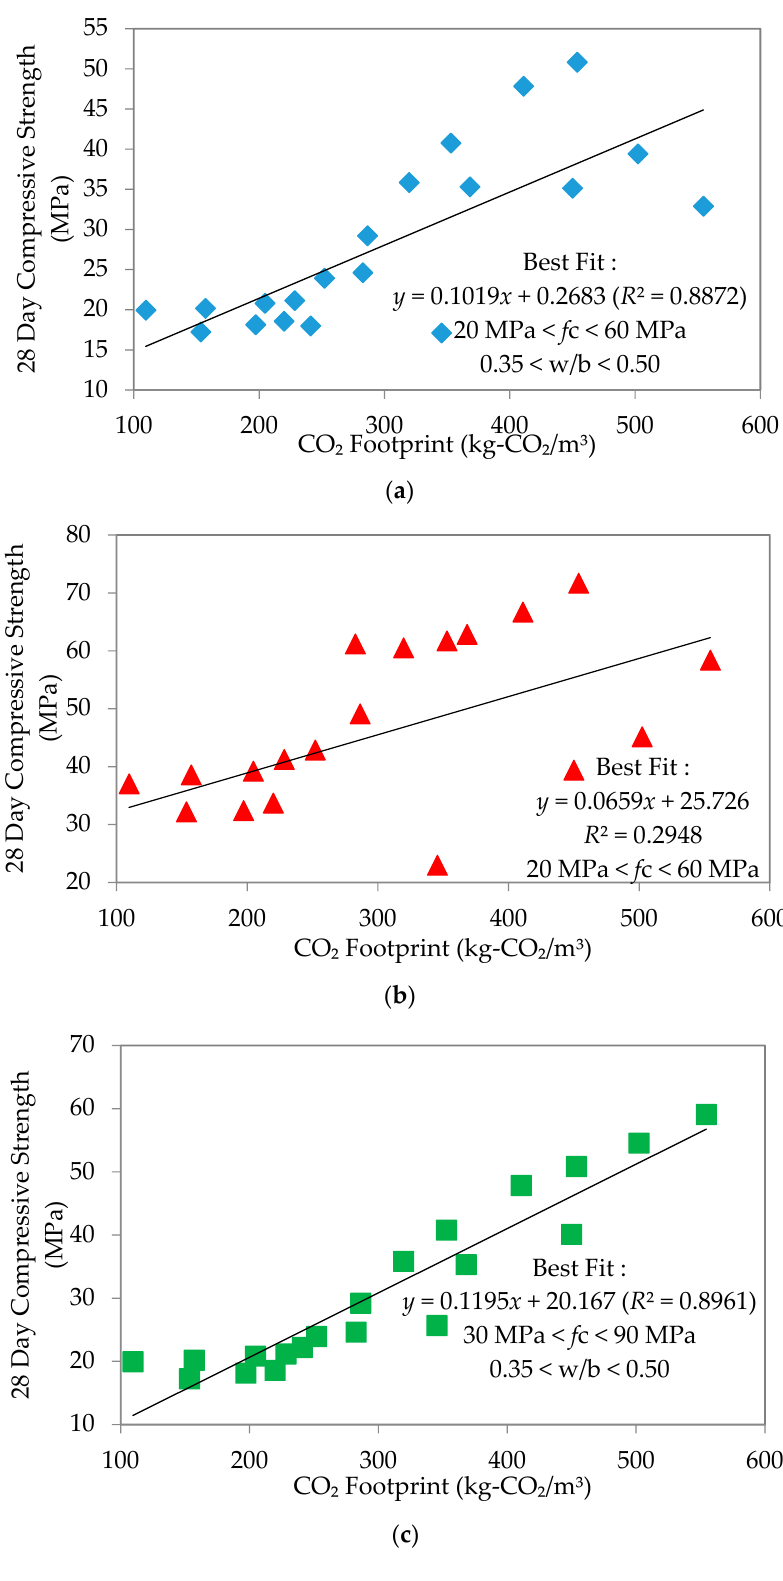
Figure 12. Compressive strength to CO 2 footprint on 28 days’ strength. ( a ) Normal flowability; ( b ) High flowability; ( c ) Self-compacting flowability.